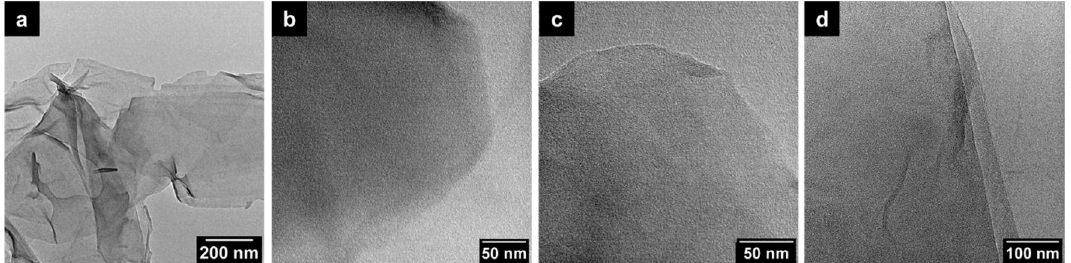
Figure 2. TEM images of ( a ) GO, ( b ) GO-100, ( c ) GO-110 and ( d ) GO-120.